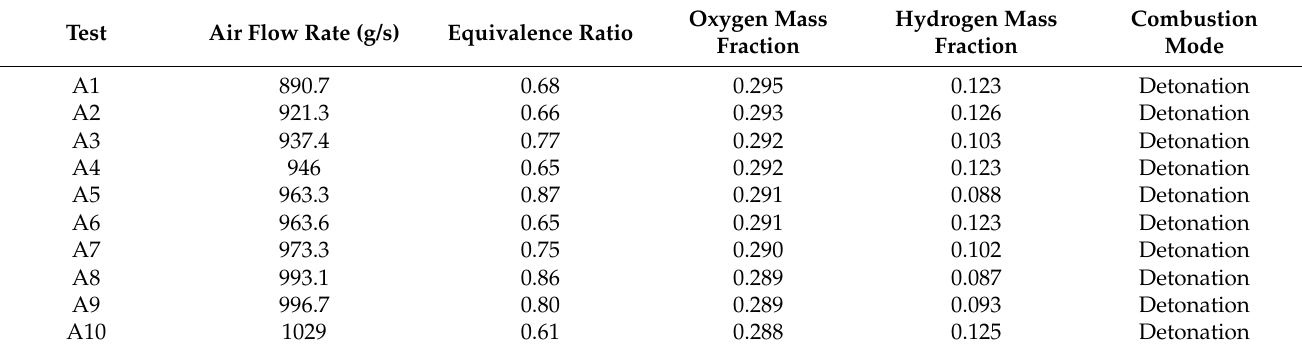
Table 2. Experimental conditions without air